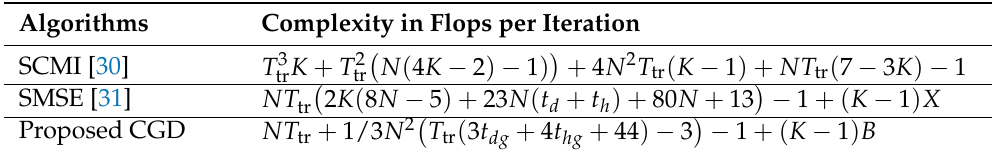
Table 1. Computational complexity analysis.